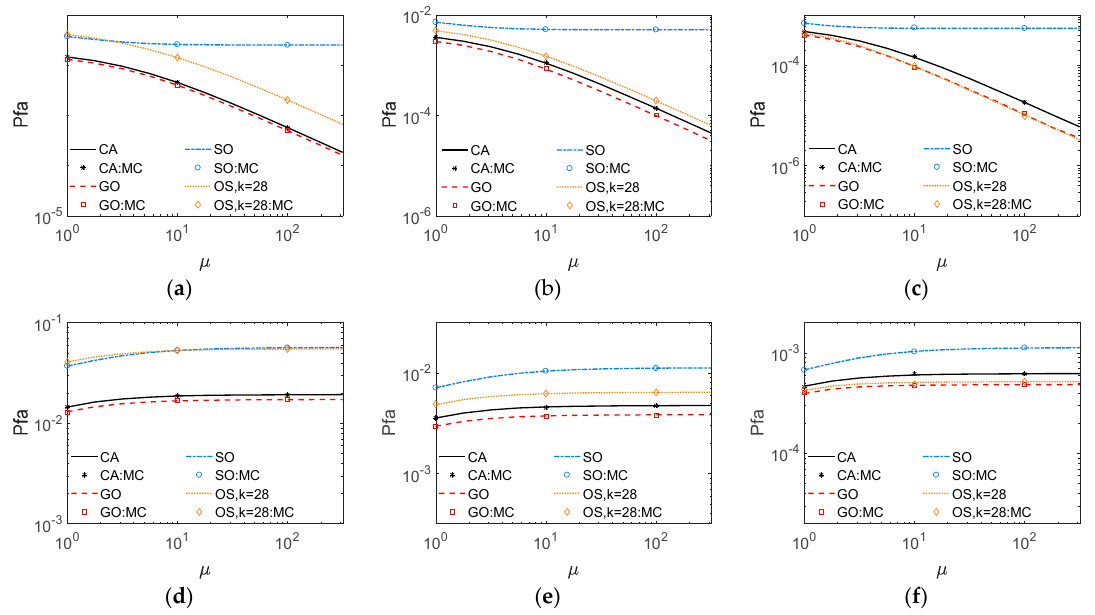
Figure 5. Real Pfas versus the designed Pfa in a nonhomogeneous P α S background. The parameters